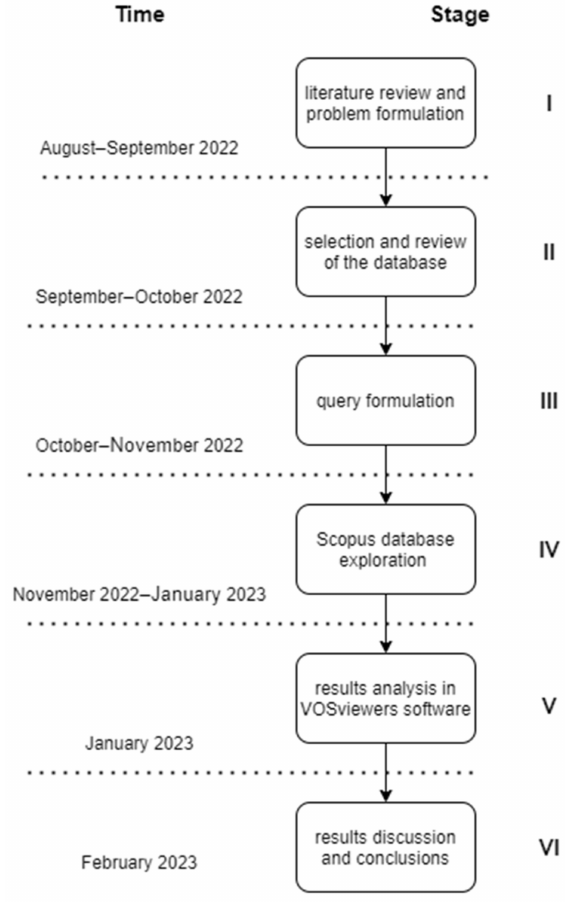
Figure 1. Research procedure stages and timeline. Source: Authors’